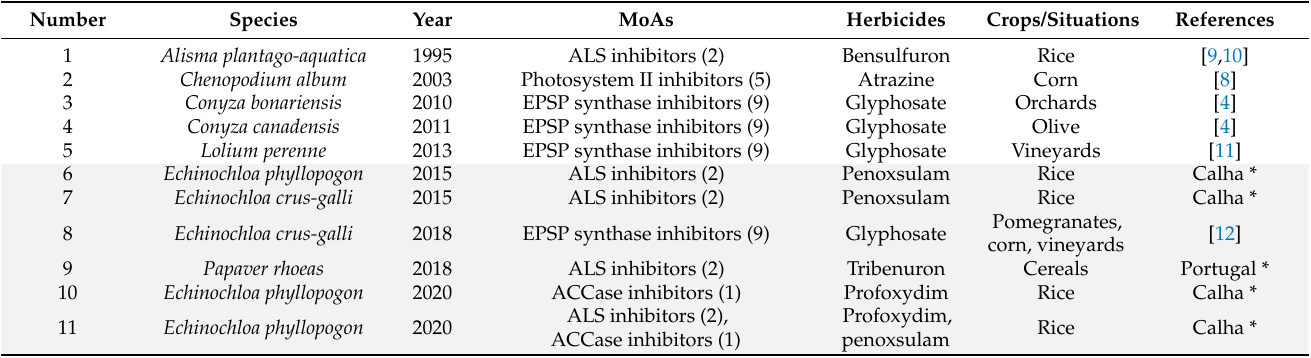
Table 1. Herbicide-resistant weeds in Portugal. Last column details the reference acknowledging the resistant case. Resistance cases under grey background (6 in total) are those not included in Heap database [4]. * Personal